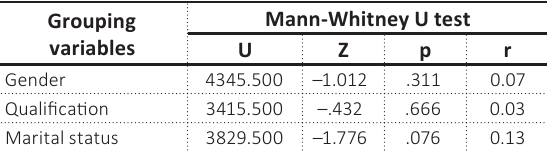
Table 4. Mann-Whitney U test